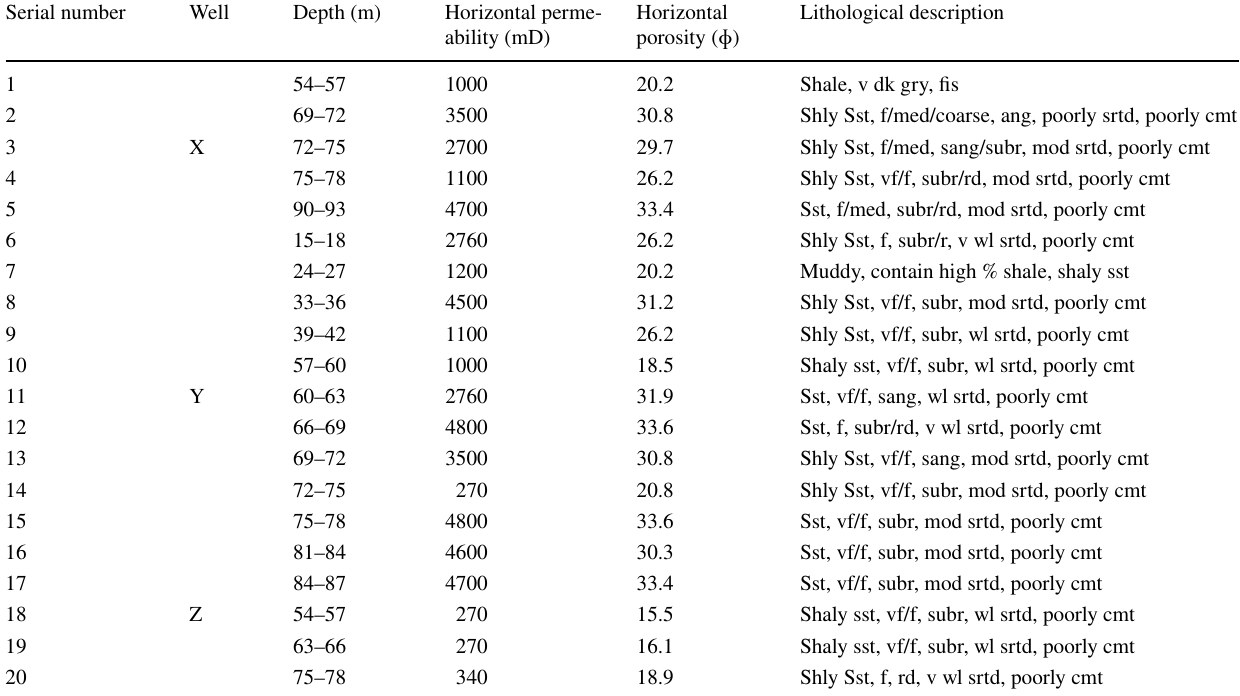
Table 5 Side wall core analysis result with the porosity and permeability values Serial